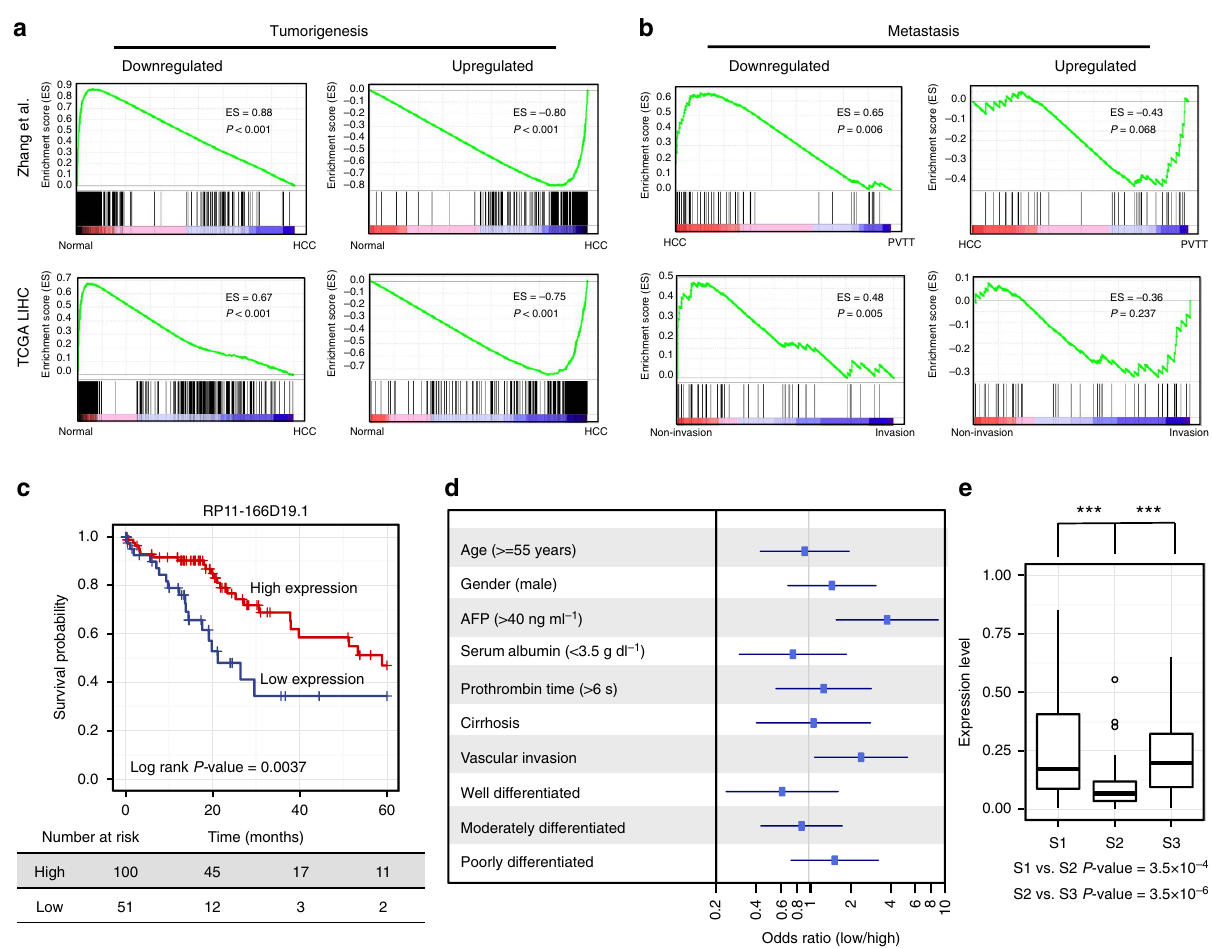
Figure 3 | Association of recurrently deregulated lncRNAs with TCGA clinical data and other published data. ( a ) Gene set enrichment analysis (GSEA) of recurrently deregulated tumorigenesis-associated lncRNAs based on TCGA LIHC data and published liver cancer data. lncRNAs were rank-ordered by differential expression between adjacent normal tissue and primary tumour samples. ( b ) GSEA of recurrently deregulated metastasis-associated lncRNAs. lncRNAs were rank-ordered by differential expression between primary tumours with and without vascular invasion in the TCGA LIHC data, as well as by differential expression between primary tumours and PVTTs in published liver cancer data. ( c ) Kaplan-Meier analysis of overall survival in the TCGA LIHC cohort. Subjects were stratified according to the expression of lncRNA RP11-166D19.1. The P value for Kaplan-Meier analysis was determined using log-rank test. ( d ) Multivariate analysis using additional clinical information. Forest plot depicting correlations between the indicated clinical criteria and the expression level of RP11-166D19.1 . ( e ) Expression levels (TCGA data) of RP11-166D19.1 in three HCC subclasses (S1, S2 and S3). *** P value o 0.001, Wilcoxon rank-sum